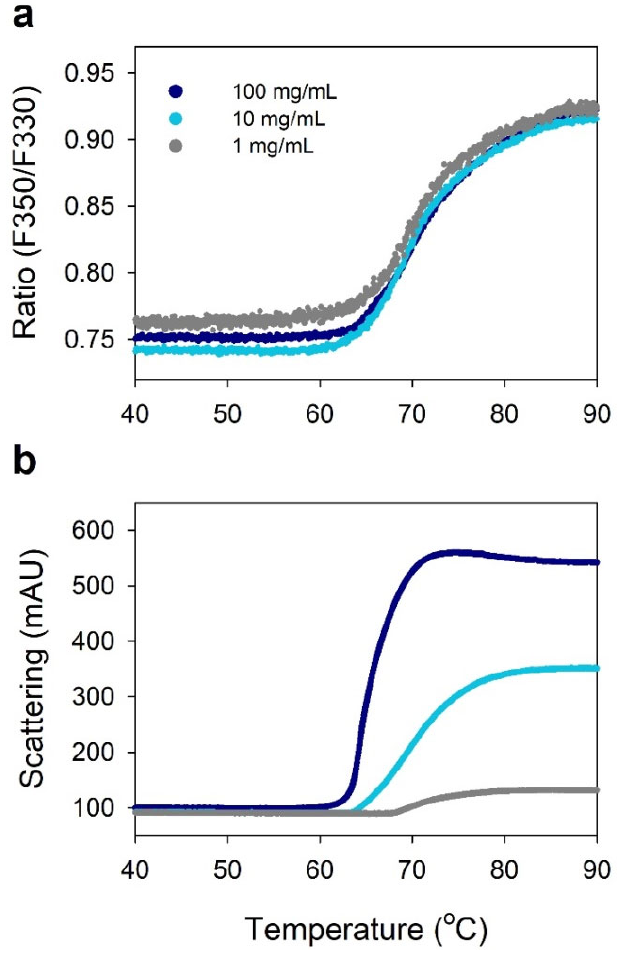
Figure 2. NanoDSF thermograms showing the effect of IgG concentration (gray—1 mg/mL; blue—10 mg/mL; dark blue—100 mg/mL) on the propensity for unfolding ( a ) and aggregation ( b ) of IgG in the 50 mM sodium phosphate buffer at pH 7.4. ( a ) NanoDSF thermogram; ( b ) Light scattering thermogram.